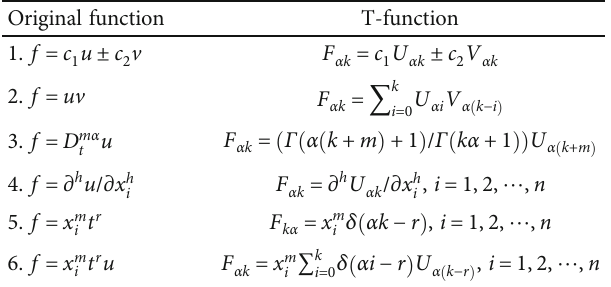
Table 1: Properties of FRDTM for 3